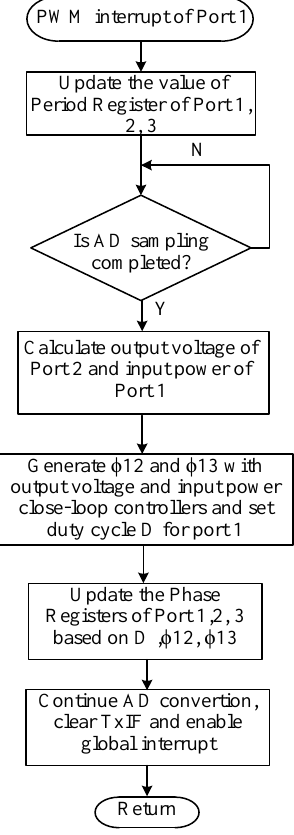
Figure 14. Flow chart of digital implementation for chaotic modulation based control for TPI bidirectional DC/DC converter.